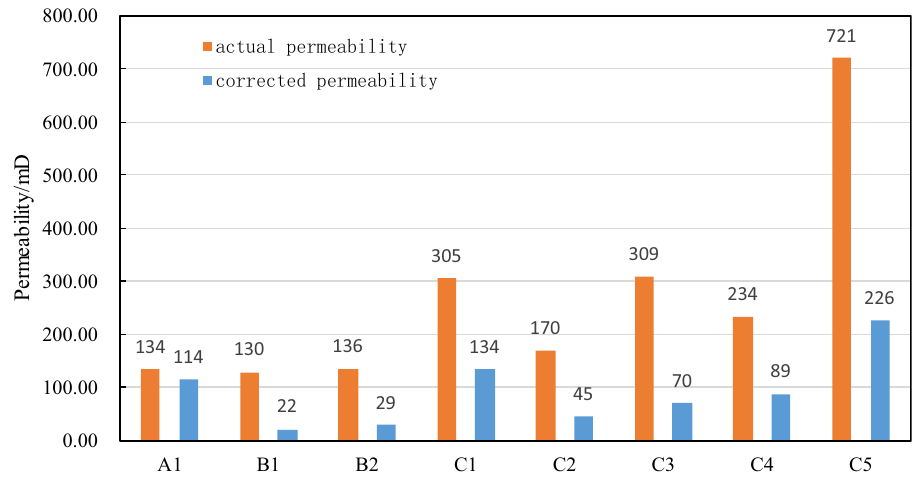
Fig. 11 Comparison between corrected permeability and actual